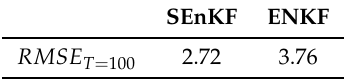
Table 2. RMSE comparing the MMAP prediction and the true log diffusivity field at time T =